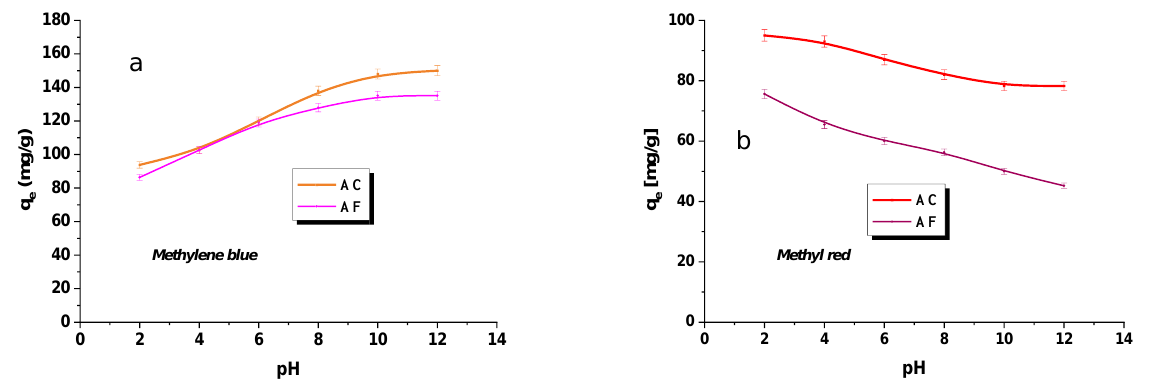
Figure 5. Effect of pH on the adsorption of methylene blue ( a )/methyl red ( b ) on activated carbon.